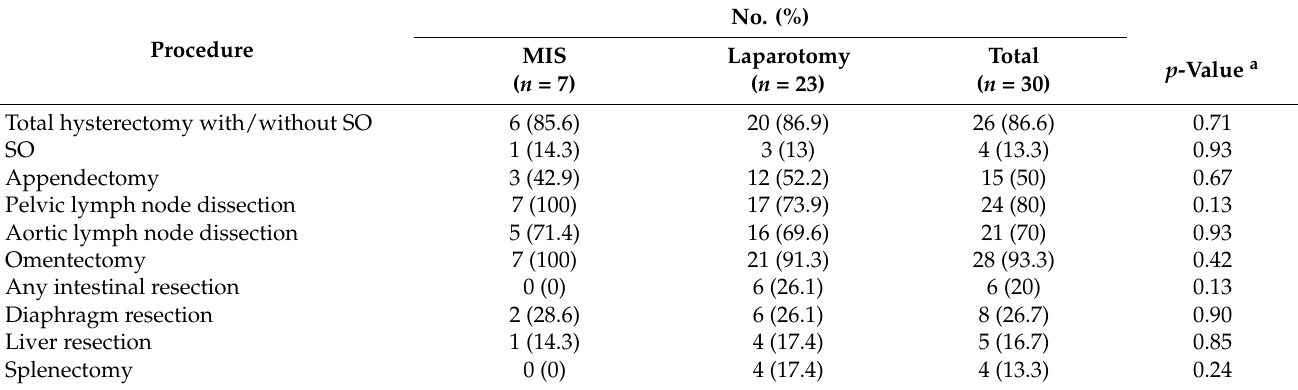
Table 6. Comparison of procedures for the interval debulking